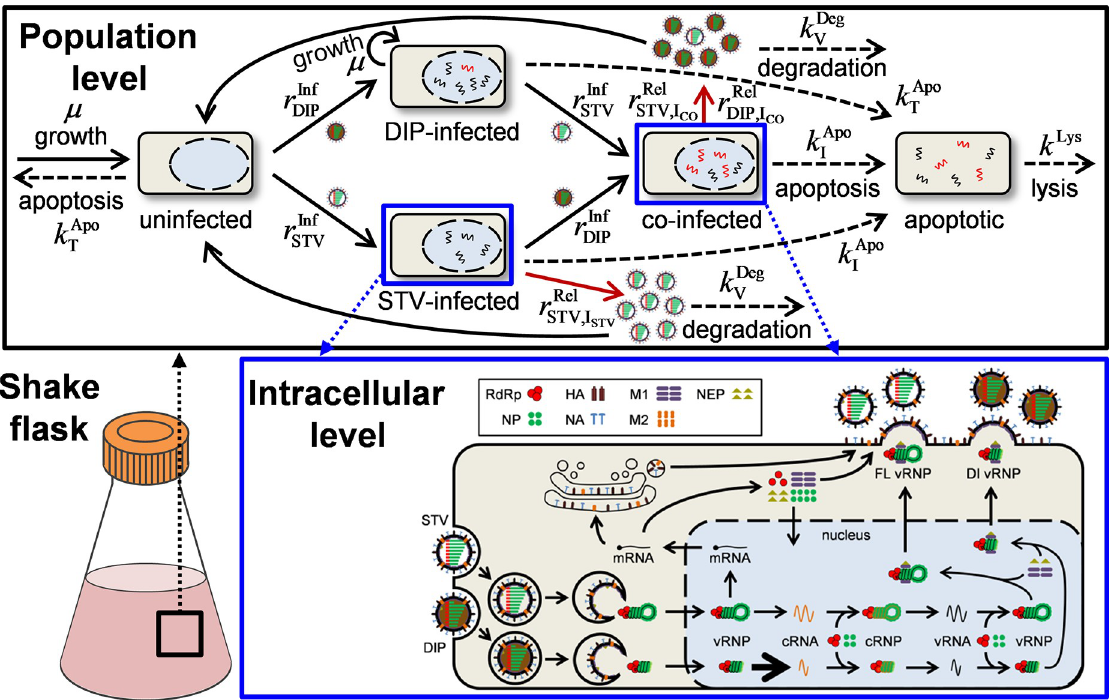
Fig 3. Schematic depiction of the multiscale STV and DIP co-infection model. (Top) The population level of infection describes growth and apoptosis of uninfected cells, their infection by either STVs or DIPs, the co-infection of STV-only infected and DIP-only infected cells, virus-induced apoptosis of all infected cells and the lysis of apoptotic cells. STVs are released from STV-only infected and co-infected cells, DIPs are only released from co-infected cells and both are cleared via virus degradation. (Bottom) Virus entry, nuclear import, viral RNA and protein synthesis, nuclear export and progeny virion release in STV-only infected cells and co-infected cells is simulated using the same intracellular model. Figure adapted from [29].